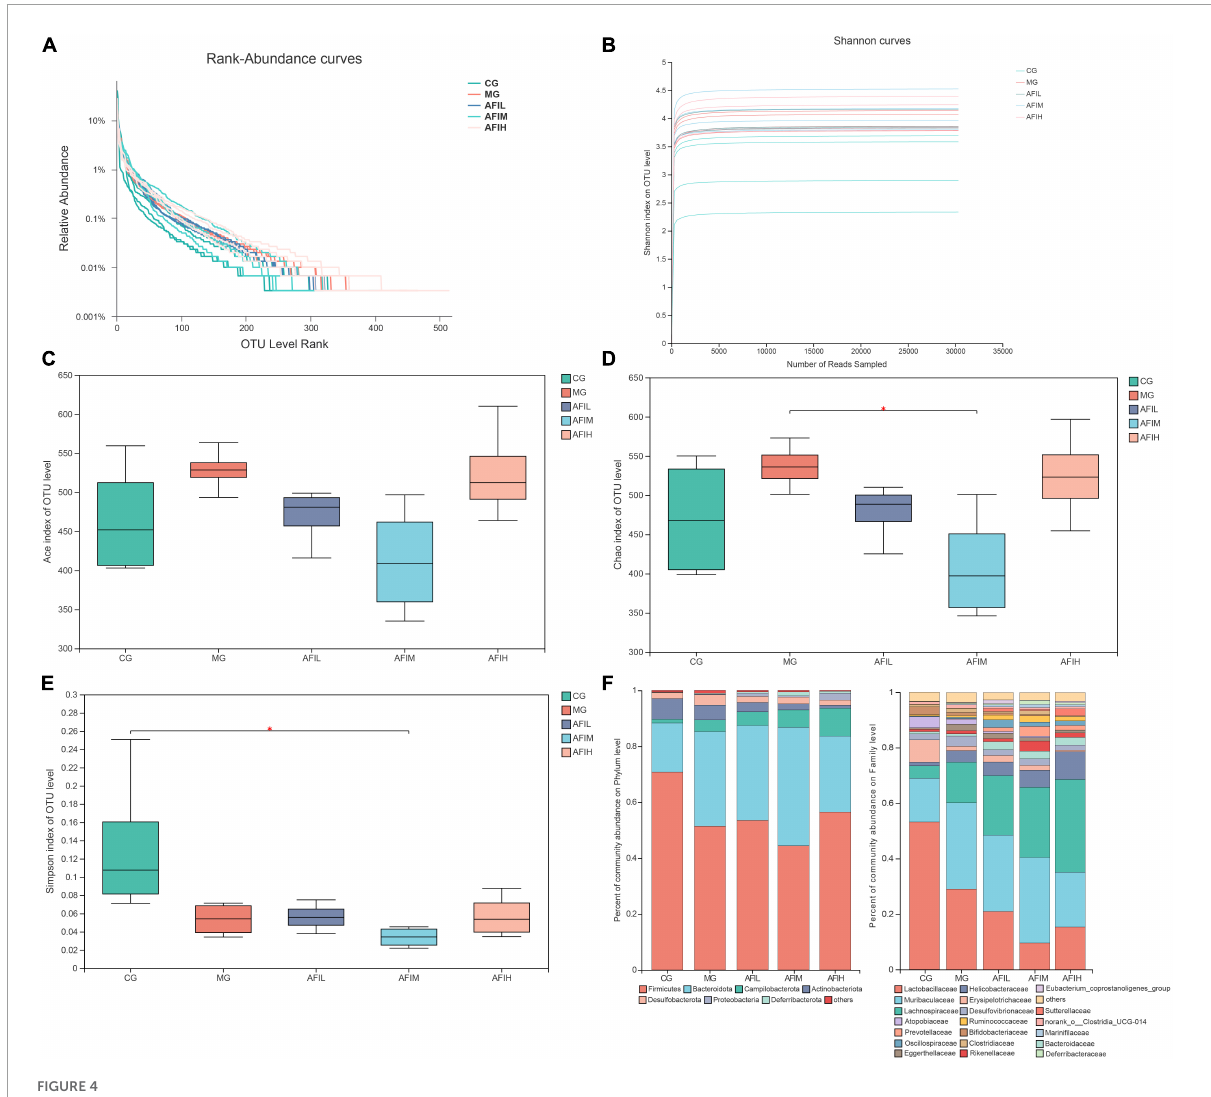
FIGURE4 Effects of AFI on the intestinal microbiota induced by DSS. (A) Rank-Abundance curves of the OUT level. (B) Shannon dilution curves. (C) ACE. (D) Chao. (E) Simpson. (F) The composition of the gut microbiota and the community bar plot analysis at the phylum and family